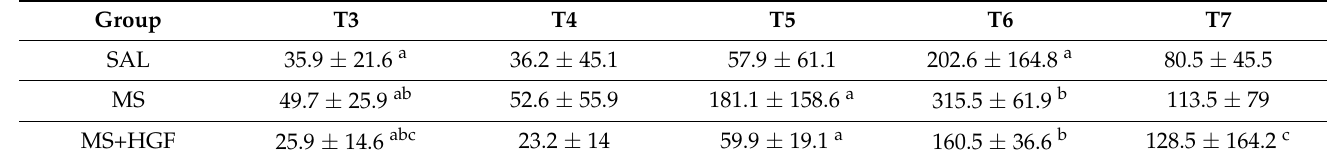
Table 5. IL-8. Mean values ± standard deviations of cytokine IL-8 (pg/mL).